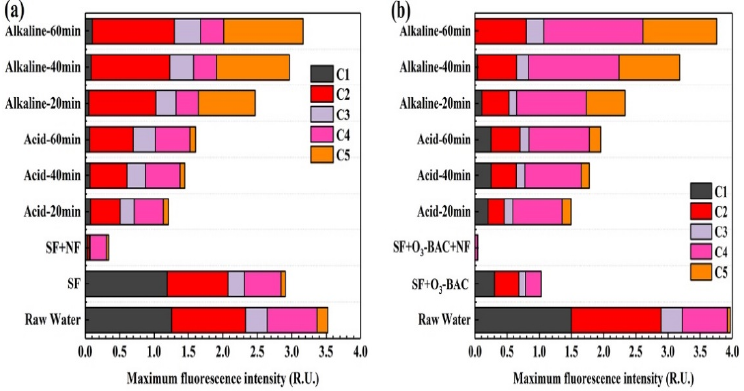
Figure 6. Relative distributions of five different FDOM components in the ( a ) SF+NF combined treatment and ( b ) SF+O 3 -BAC+NF combined treatment.